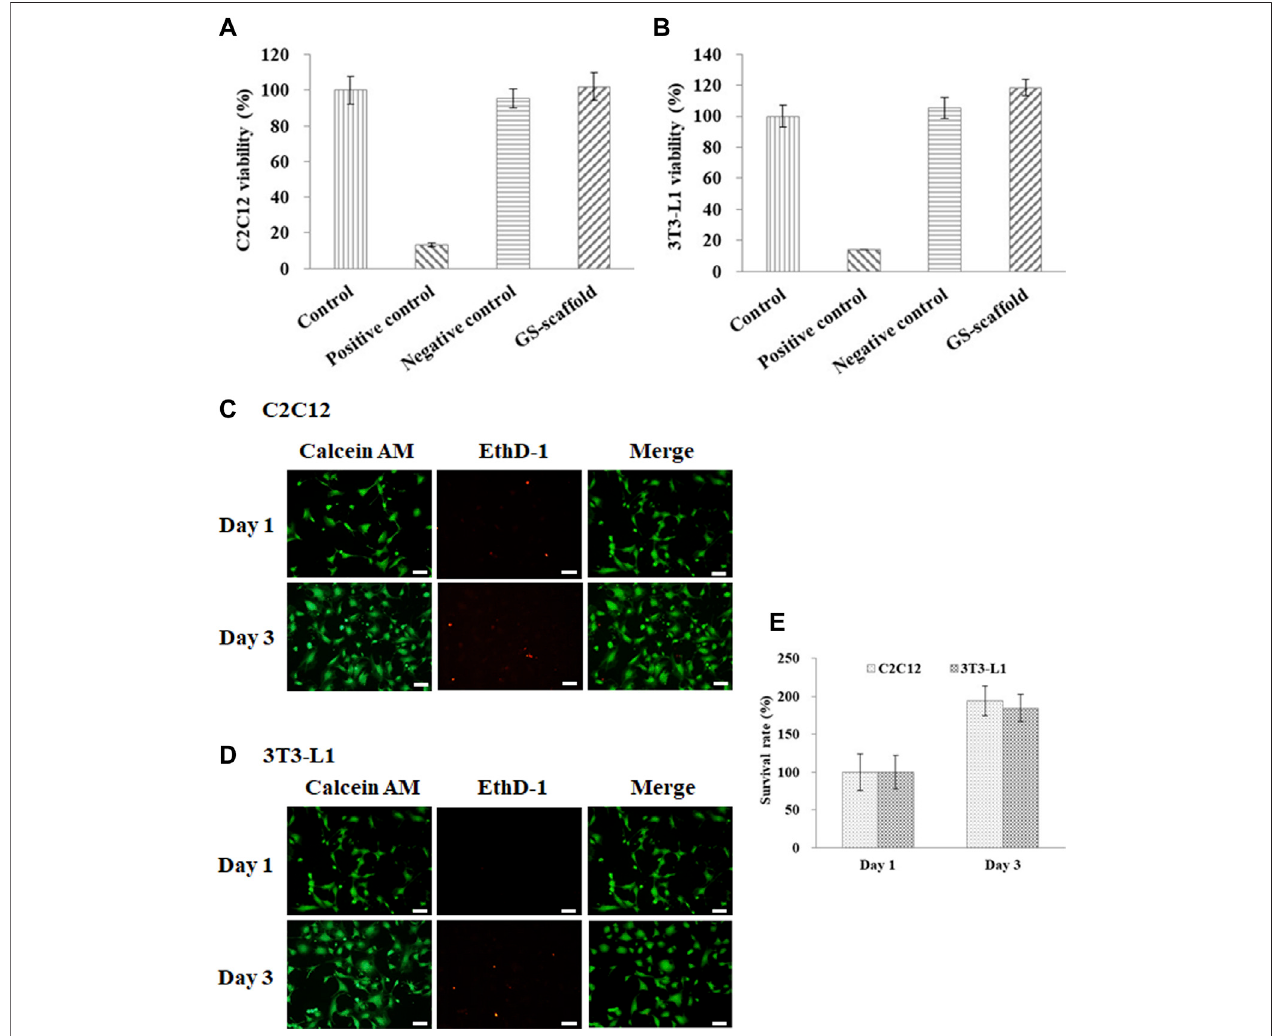
FIGURE1| Cellviabilityandsurvivalrateofthe (A) C2C12and (B) 3T3-L1cellswereevaluatedbasedontheguidelinesprovidedbytheISO-10993.Theresultsare in terms of cytotoxicity. The cells cultured with medium served as the control group, where the cells cultured with the extracts from ZDEC and Al 2 O 3 were used as the positiveandnegativecontrols,respectively.Dataarepresentedasthemean±SD,n=6,intwoindependentexperiments.Thecellviabilityofthe (C) C2C12and (D) 3T3-L1 cells on the GS scaffold were evaluated by live/dead staining. Cells were grown on the GS scaffold and analyzed at day 1 and 3. The living cells in green were stained with Calcein AM, and the dead cells in red were stained with EthD-1 (scale bar = 50 μ m). (E) The quanti fi cation of the C2C12 and 3T3-L1 cells by live/dead staining.